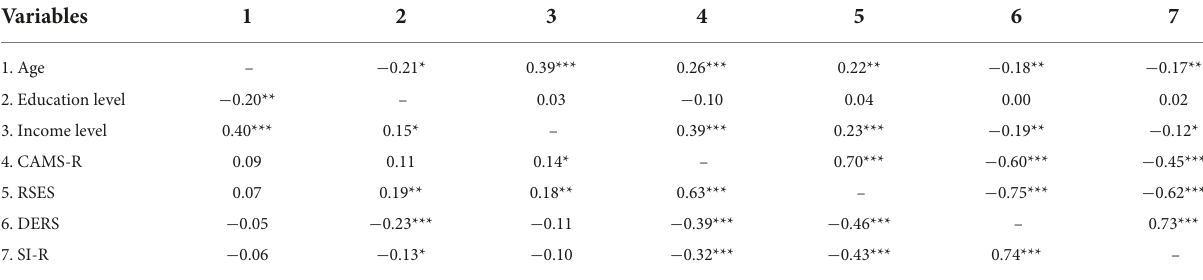
TABLE 3 Results of pairwise correlation analysis of all